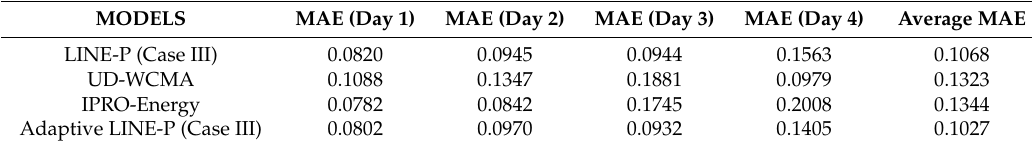
Table 8. Error comparison of the prediction models based on MAE for the SCE solar energy profile. MODELS